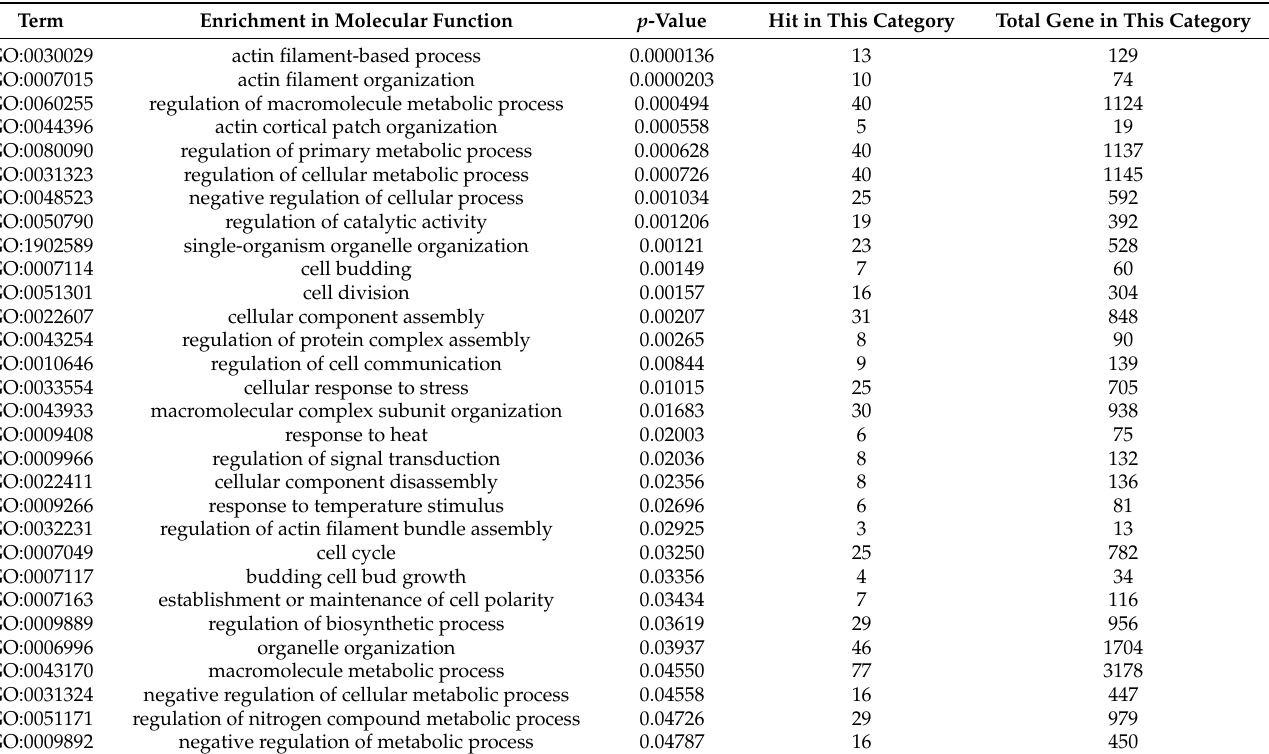
Table 1. Enrichment categories in Gene Ontology (GO) biological processes for the protein targets of Sub5. Term